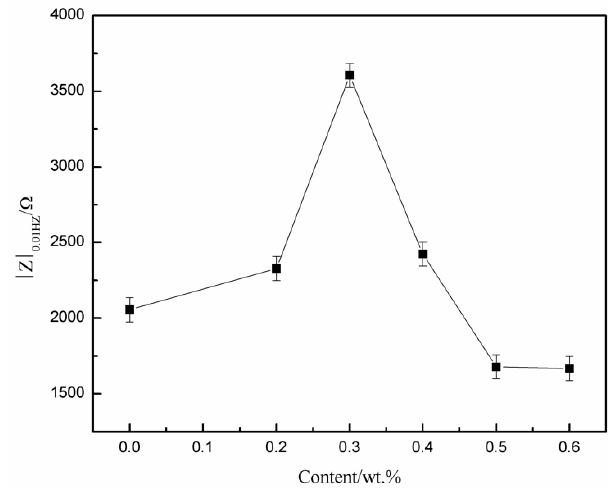
Figure 5. |Z| 0.01HZ values of MWCNTs/WPU conductive coatings with different MWCNTs contents.